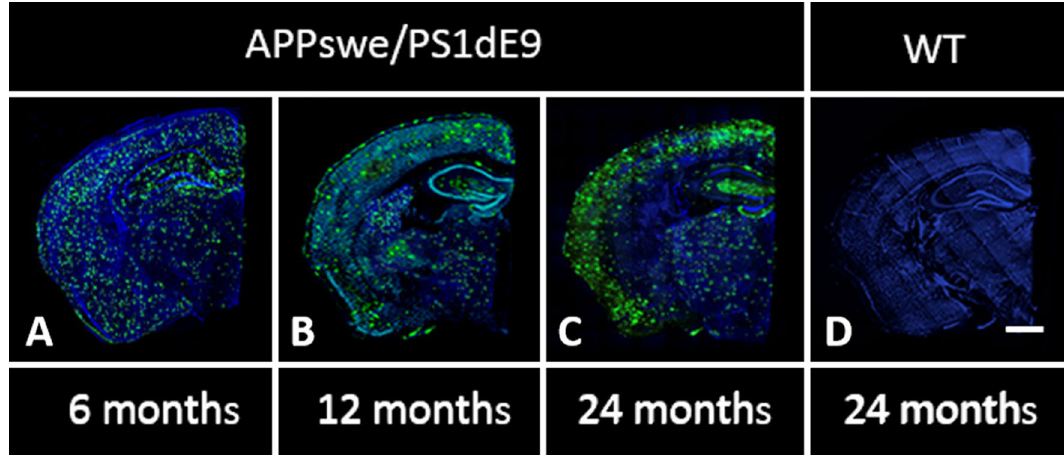
Figure 1. Spatial distribution of Aβ-deposits in hemibrain from APPswe/PS1dE9 mice at different ages, compared to an representative image from a 24-month old WT mouse. Aβ-deposits in ( A ) 6-month old, ( B ) 12-month old and ( C ) 24-month old APPswe/PS1dE9 mouse. ( D ) 24-month old WT mouse, stained for but without any evident hemibrain Aβ-deposits. Coronal section 50 µm. (×10). Anti-Aβ (green) and bismencimide (blue). Bar 1